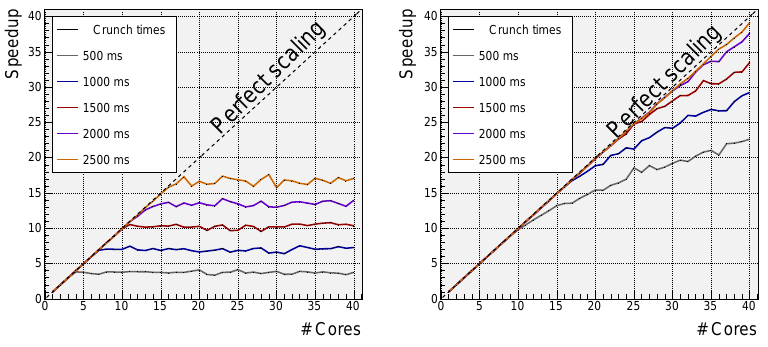
Figure 3. Application speed-up without using the LCIO lazy unpacking (left) and with LCIO lazy unpacking